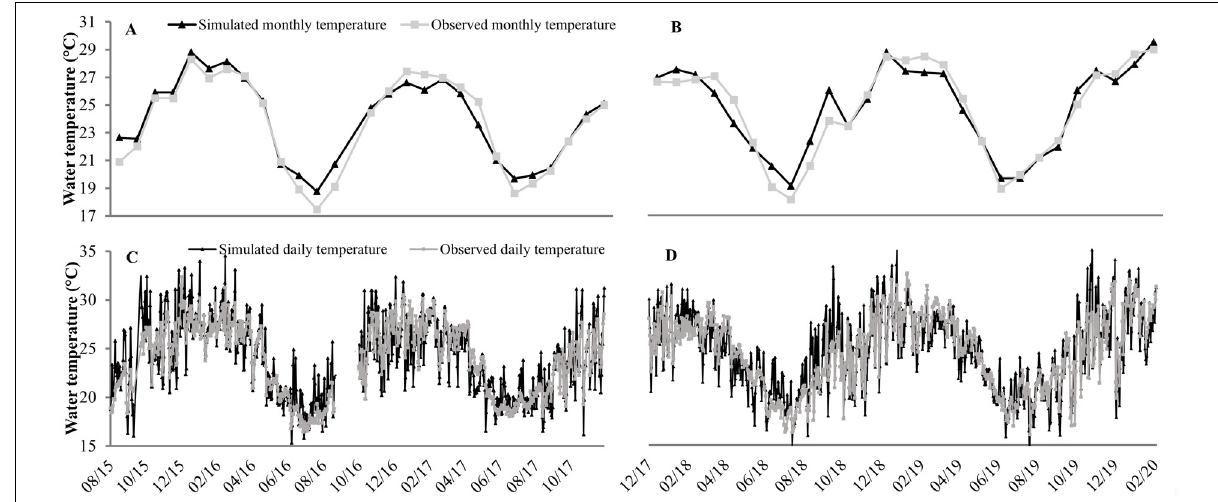
Figure 2: Hydrothermographs of (A, B) monthly model calibration (black) and observed (grey) water temperatures, and (C, D) daily model calibration (black) and observed (grey) water temperatures, for periods August 2015 to November 2017 (A, C) and December 2017 to February 2020 (B, D), for Mamba Weir, Olifants River, South Africa. The gap in C is due to 13 days of missing observational data during September